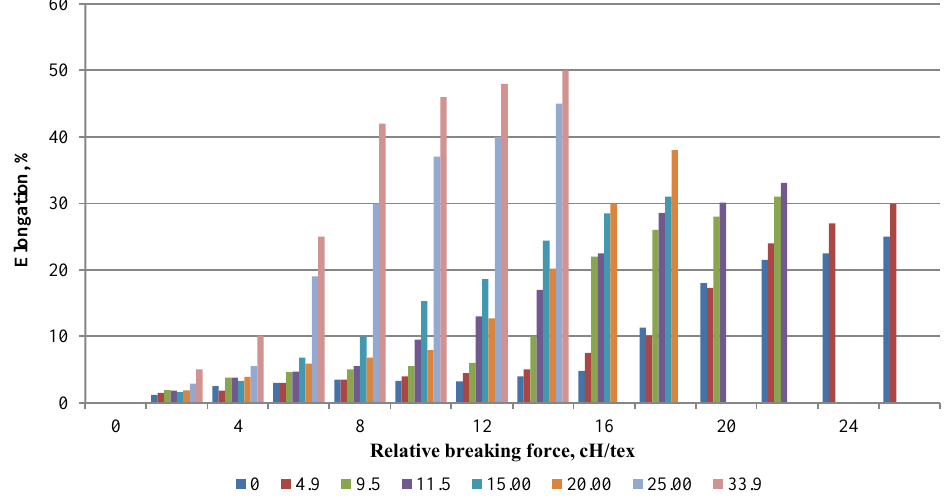
Fig. 5. Histogram of stretching of wool fibres at their different moisture